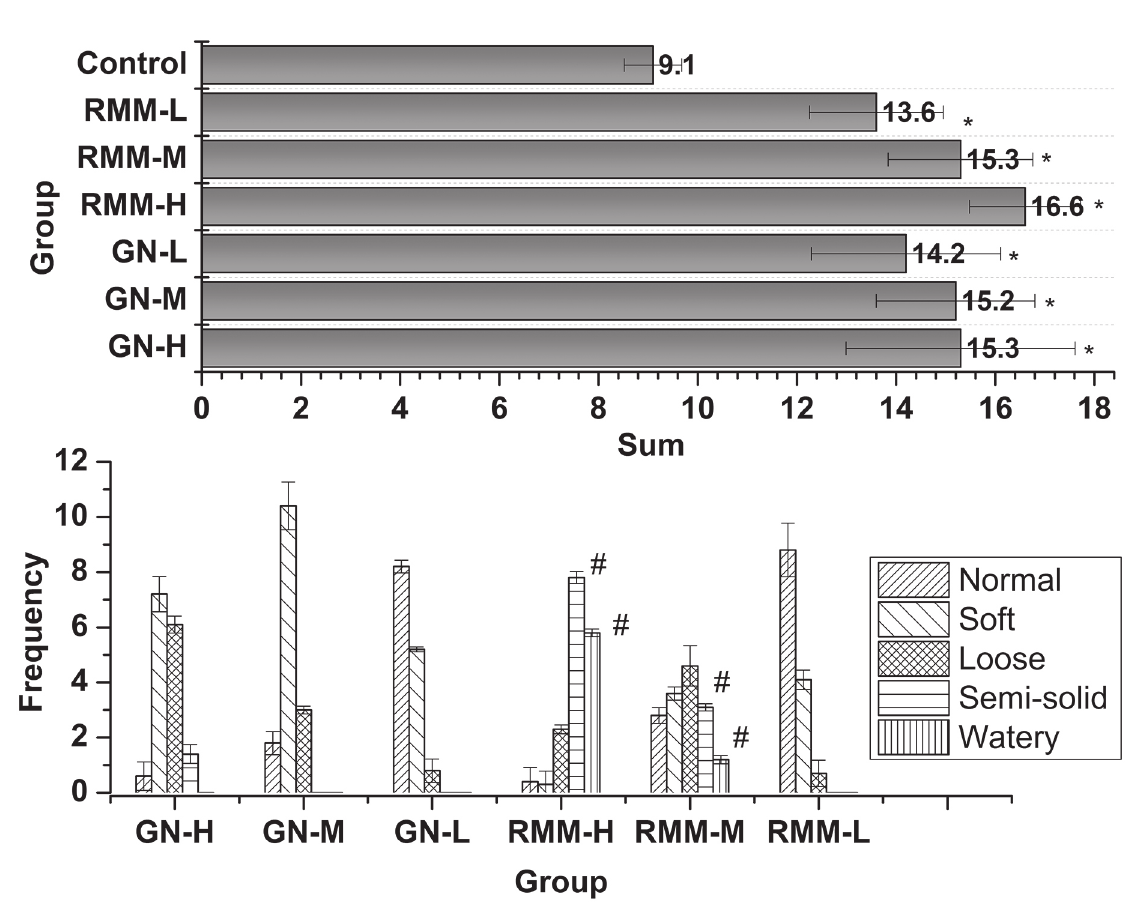
FIGURE 6 - The comparison on defecation frequency and consistance of faeces of RMM and RTA-OCDD-GN groups after oral administration to rats. The data were expressed as mean ± S.D. (n = 10). * P < 0.05, compared with the normal group; # P <0.05, compared with the RTFA-OCDD-GN